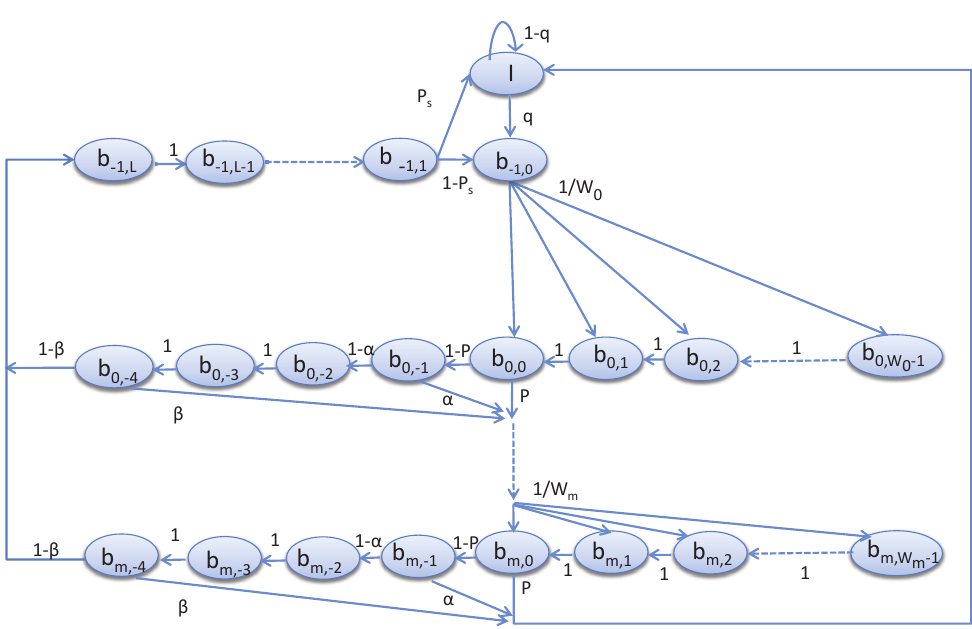
Figure 5. Markov model for the proposed CSMA-CA